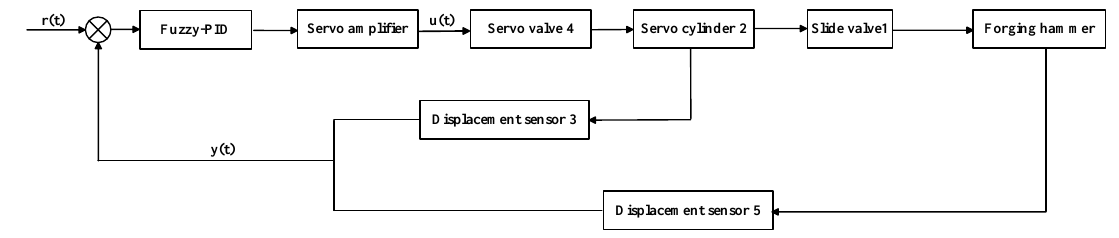
Figure 11. Automatic control system of the free forging hammer.